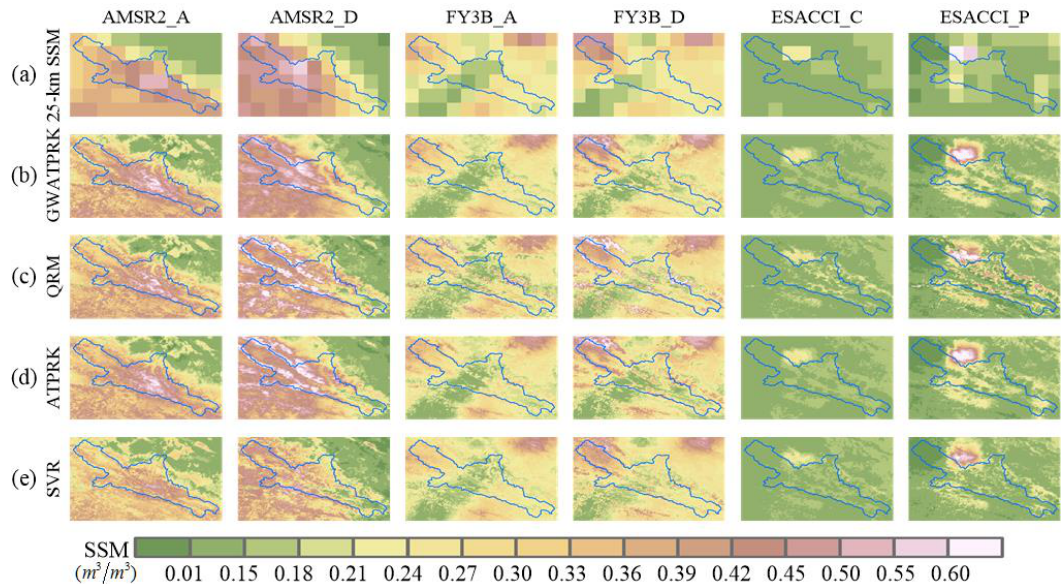
Figure 6. Upper HBR area on 14 August 2012. ( a ) Various 25 km SSM images and downscaled 1 km SSM images derived using the four methods: ( b ) GWATPRK, ( c ) QRM, ( d ) ATPRK, and ( e ) SVR.